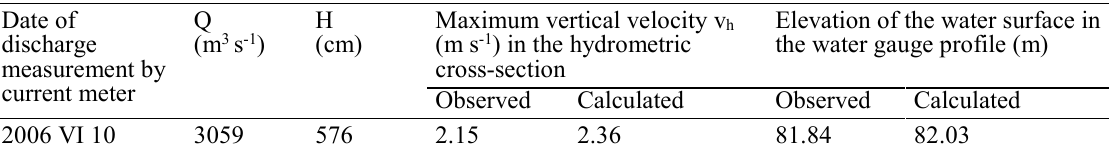
Table 2 Comparison of the observed and calculated hydraulic parameters obtained by IMGW from current meter hydrometric measurement at Świętokrzyski Bridge and the CCHE2D